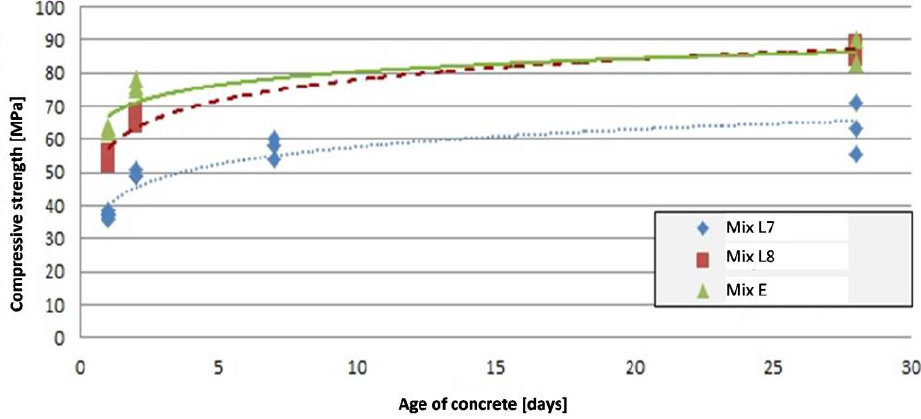
Figure 1. Compressive strength as function of concrete age (LWAC: Mix L7 and L8; NWAC: Mix E).